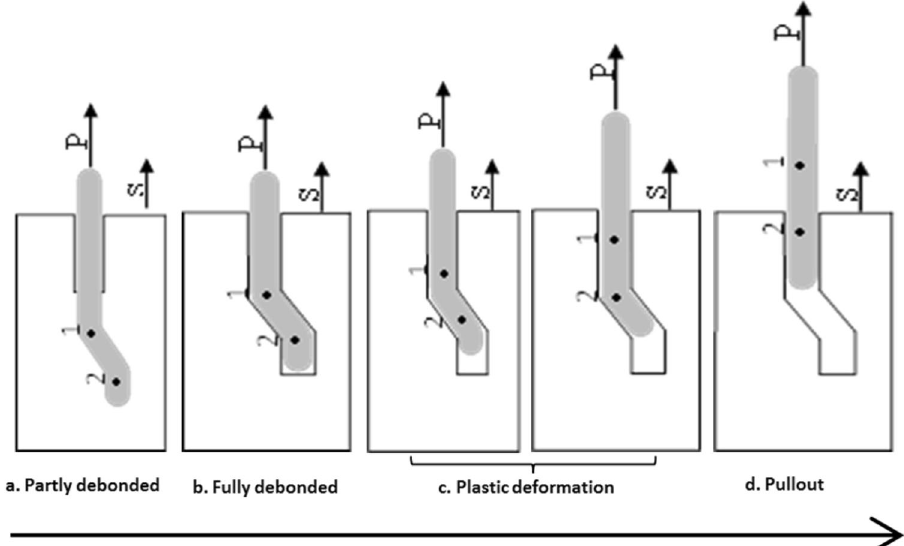
Fig. 12 Pullout process of a hooked end steel